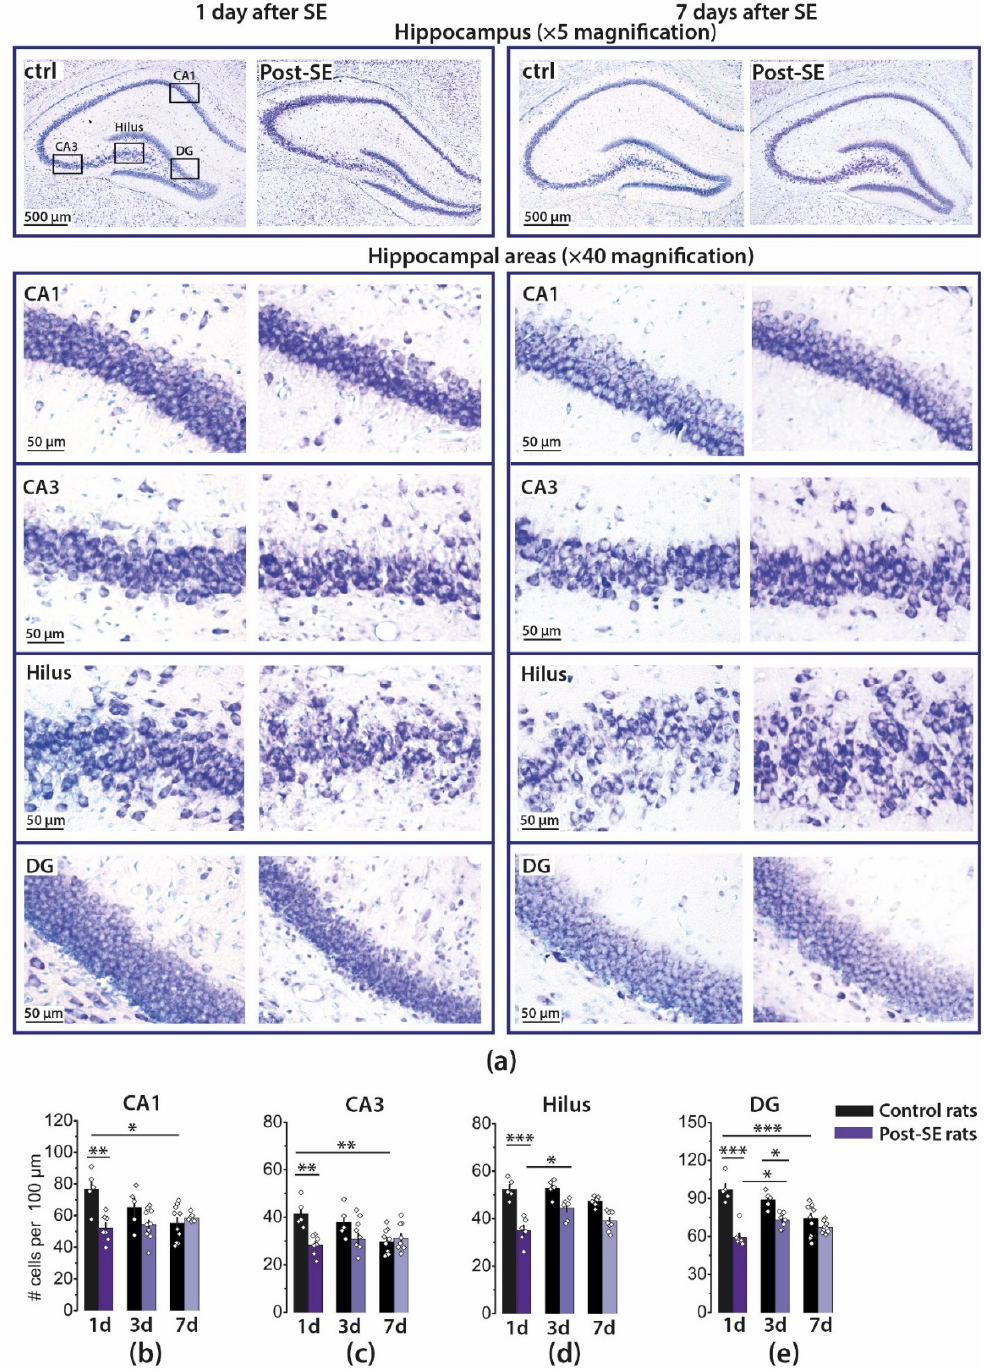
Figure 1. Pilocarpine-induced SE provokes neuronal loss in the hippocampus of young rats. ( a ) Representative sections of the Nissl staining of the different hippocampal areas CA1, CA3, hilus, and dentate gyrus (DG) in control (ctrl) and 7d post-SE rats. Group data of the counted Nissl-stained neurons per 100 μ m in the hippocampal areas: CA1 ( b ), CA3 ( c ), hilus ( d ), and DG ( e ). Five to nine animals were in each group. The diamonds show the individual values for each rat. The bars indicate average values, and error bars show standard errors of the means. Two-way ANOVA was performed to determine the effects of SE, time after SE, and interaction of these factors: CA1 (SE: F 1, 39 = 12.5, p < 0.01; time: F 2, 39 = 2.2; p = 0.13; SE × time: F 2, 39 = 7.3, p < 0.01); CA3 (SE: F 1, 38 = 9.1, p < 0.01; time: F 2, 38 = 3.7; p < 0.05; SE × time: F 2, 38 = 5.8, p < 0.01); hilus (SE: F 1, 34 = 79, p < 0.001; time: F 2, 34 = 7.2; p < 0.01; SE × time: F 2, 34 = 5.3, p < 0.01); DG (SE: F 1, 38 = 58, p < 0.001; time: F 2, 38 = 6.4; p < 0.01; SE × time: F 2, 38 = 12, p < 0.001). * p < 0.05, ** p < 0.01, *** p < 0.001 (Tukey’s post hoc